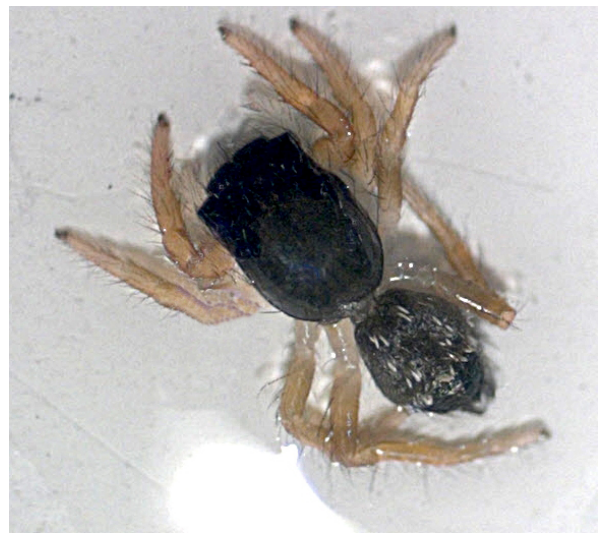
Figure 3. Single tropical baby spider of a cocoon on a banana sur- face: note the larger rectangular cephalothorax and the smaller oval abdomen (0.4cm in total body length). Figure 4. Scanning electron microscopical image of a baby spider from a cocoon on a banana: large anterior median pair of eyes indi- cating jumping spiders